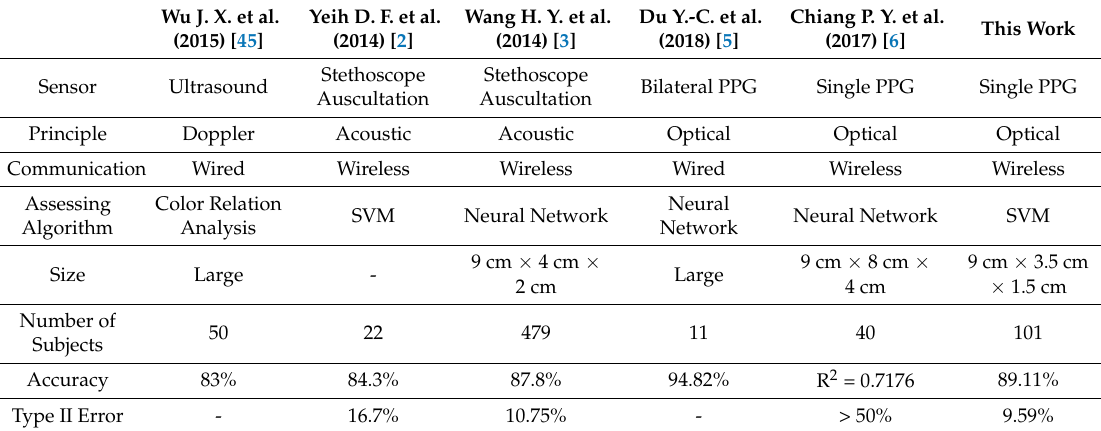
Table 4. Comparison table among developed methods of assessing